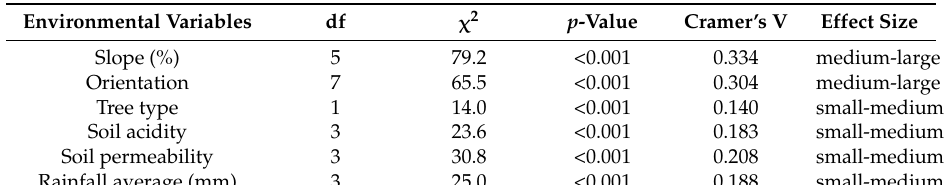
Table 3. Environmental variables for which a significant association with Armillaria spp. was observed. Pearson’s chi square value ( χ 2 ), degrees of freedom (df), p -value, Cramer´s V value, and effect size are shown for each environmental variable.